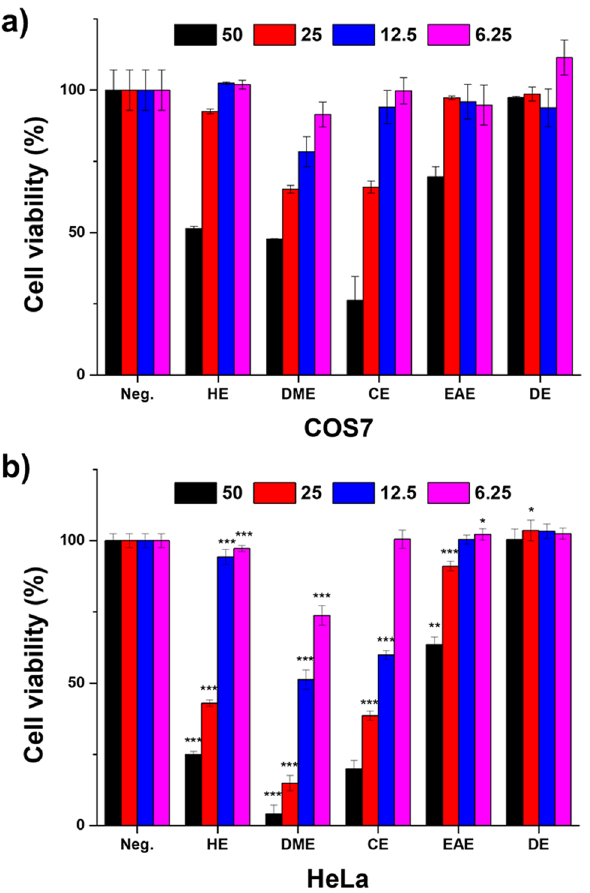
Figure 2. Anticancer effects of various extracts of M. glyptostroboides. ( a ) COS7 and ( b ) HeLa cells were incubated for 24 h with M. glyptostroboides extracts at 50, 25, 12.5, and 6.25 µg/ml. ***p < 0.001 indicate statistical significances compared to